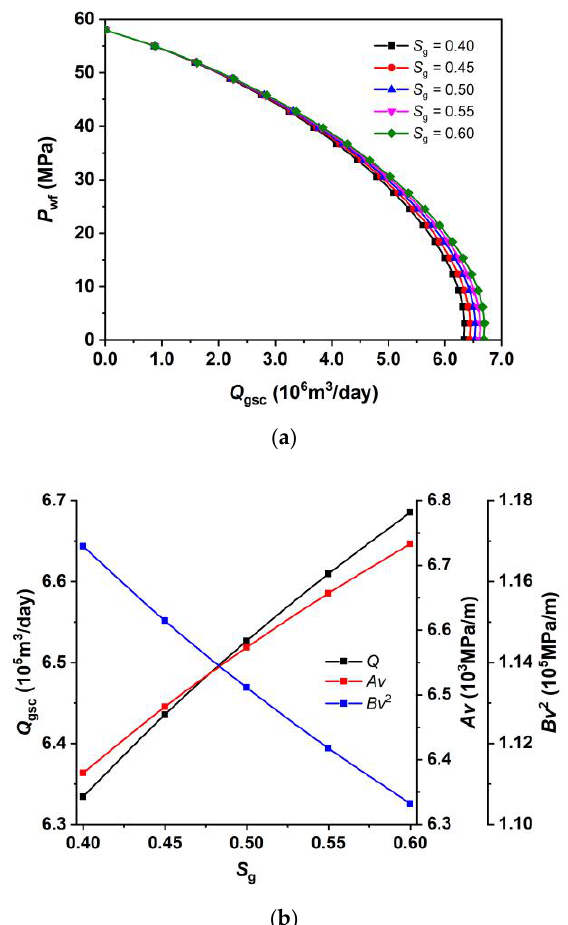
Figure 9. Effect of initial gas saturation on gas production rate and flow characteristics. ( a ) IPR curves with different initial gas saturation. ( b ) Characteristic analysis of flow regime at the well bottom hole.